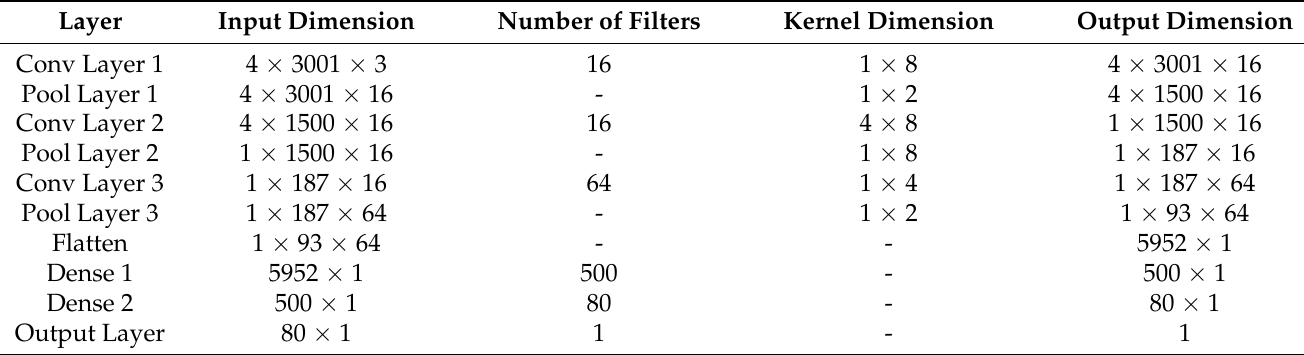
Table 1. A detailed summary of the CNN architecture, showing the number and dimensions of filters and neurons at each layer of the